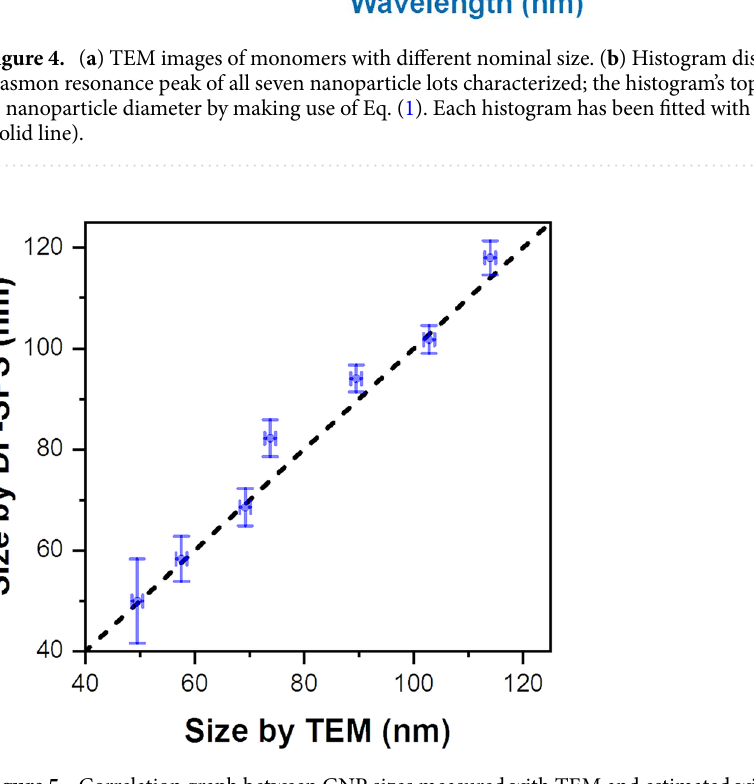
Figure 5. Correlation graph between GNP sizes measured with TEM and estimated with DF-SPS. The dashed red line in the graph represents a perfect linear